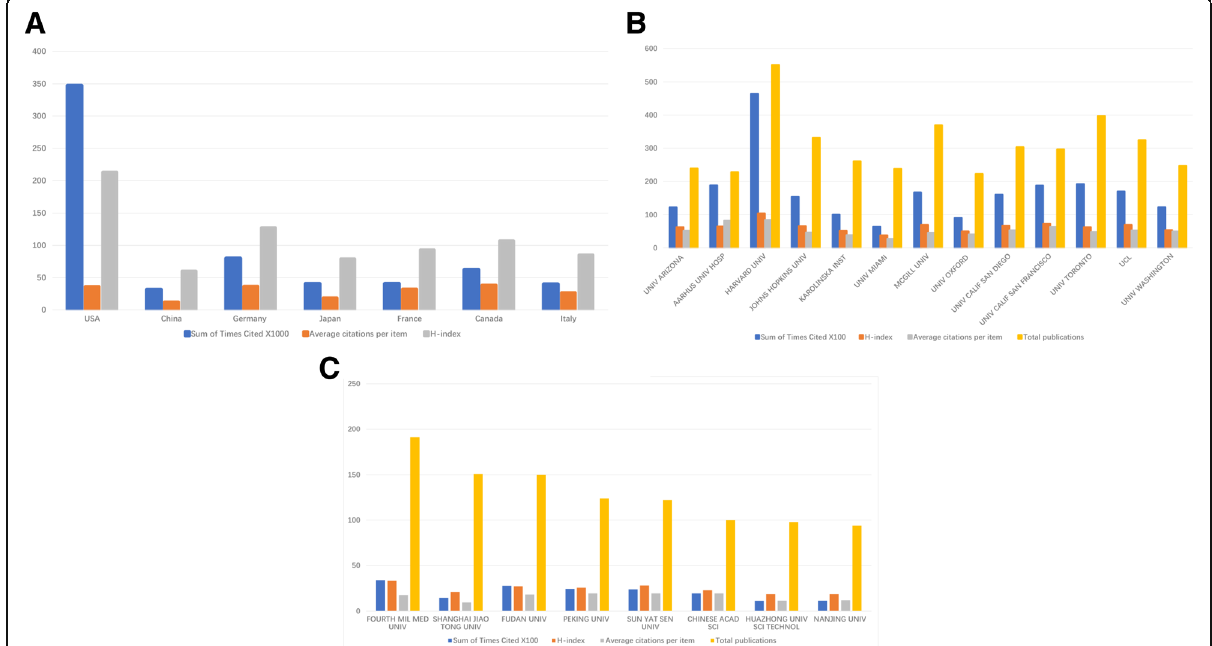
Fig. 2 Citations and h-index analysis in world and China ( a ) The total citations, average citations per paper and H-index for neuropathic pain articles from top countries. ( b ) The total citations, average citations per paper and H-index for neuropathic pain articles in the global institutions.